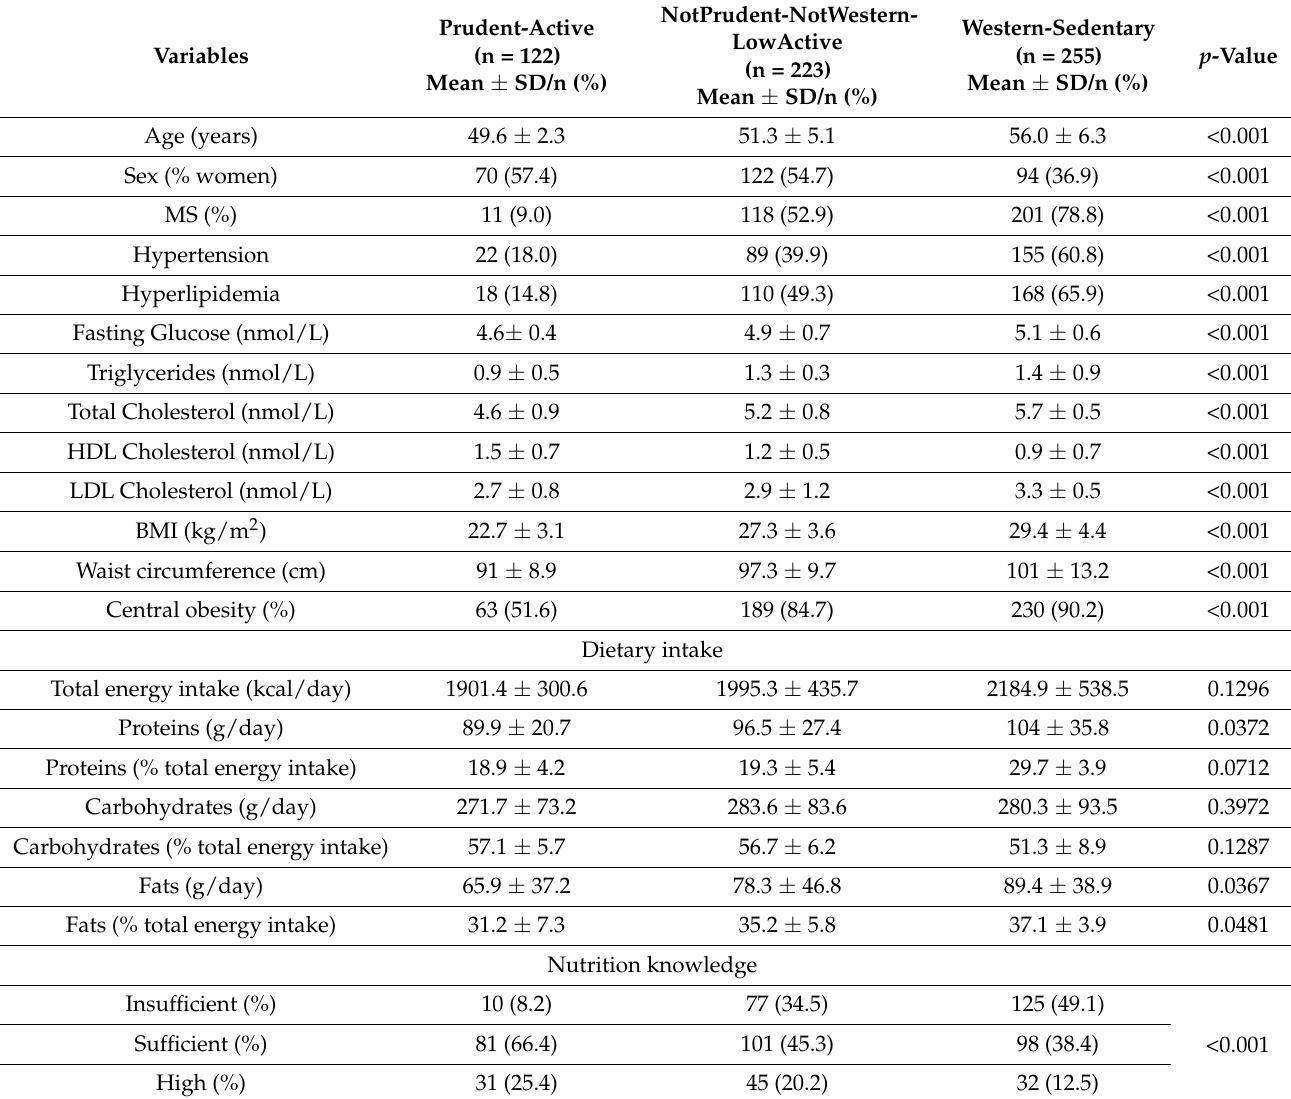
Table 3. Study population according to dietary-lifestyle patterns.